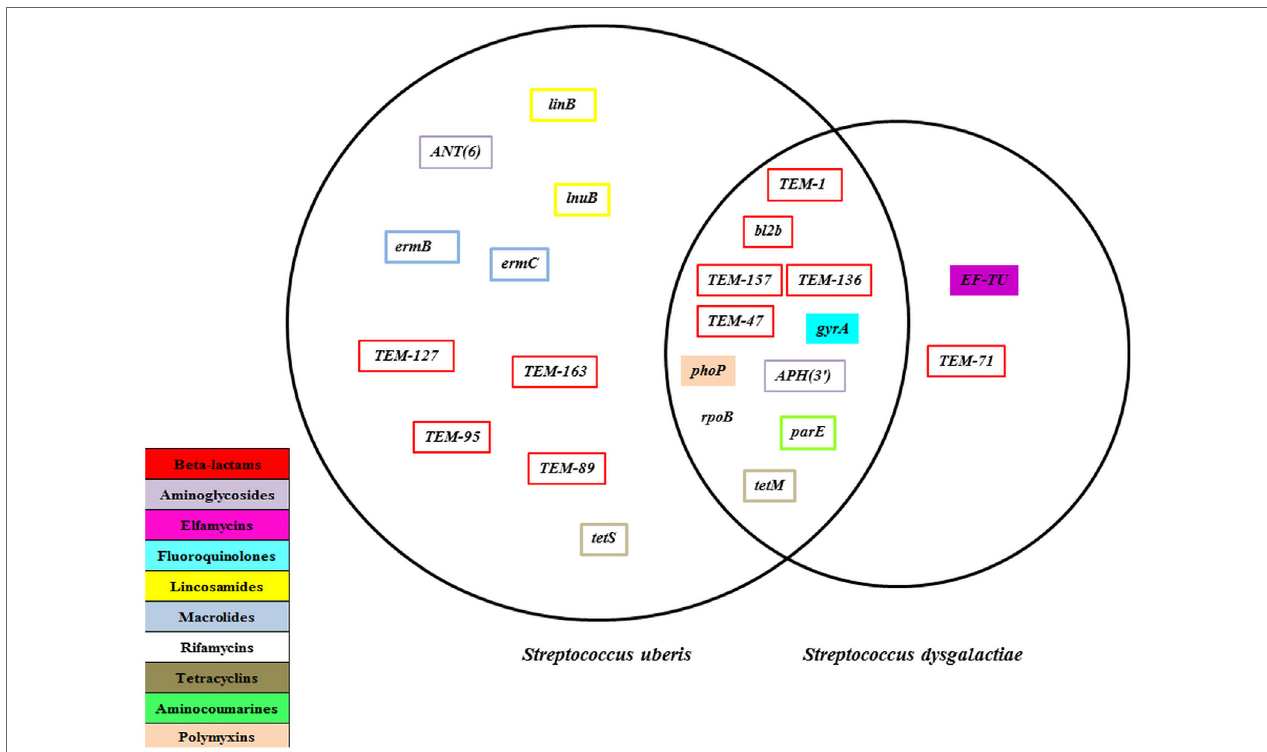
FigUre 1 | antimicrobial resistance genes present for Streptococcus uberis ( n = 64) and Streptococcus dysgalactiae ( n = 25) isolates recovered from dairy herds from the Maritime province of canada, 2007 and 2008